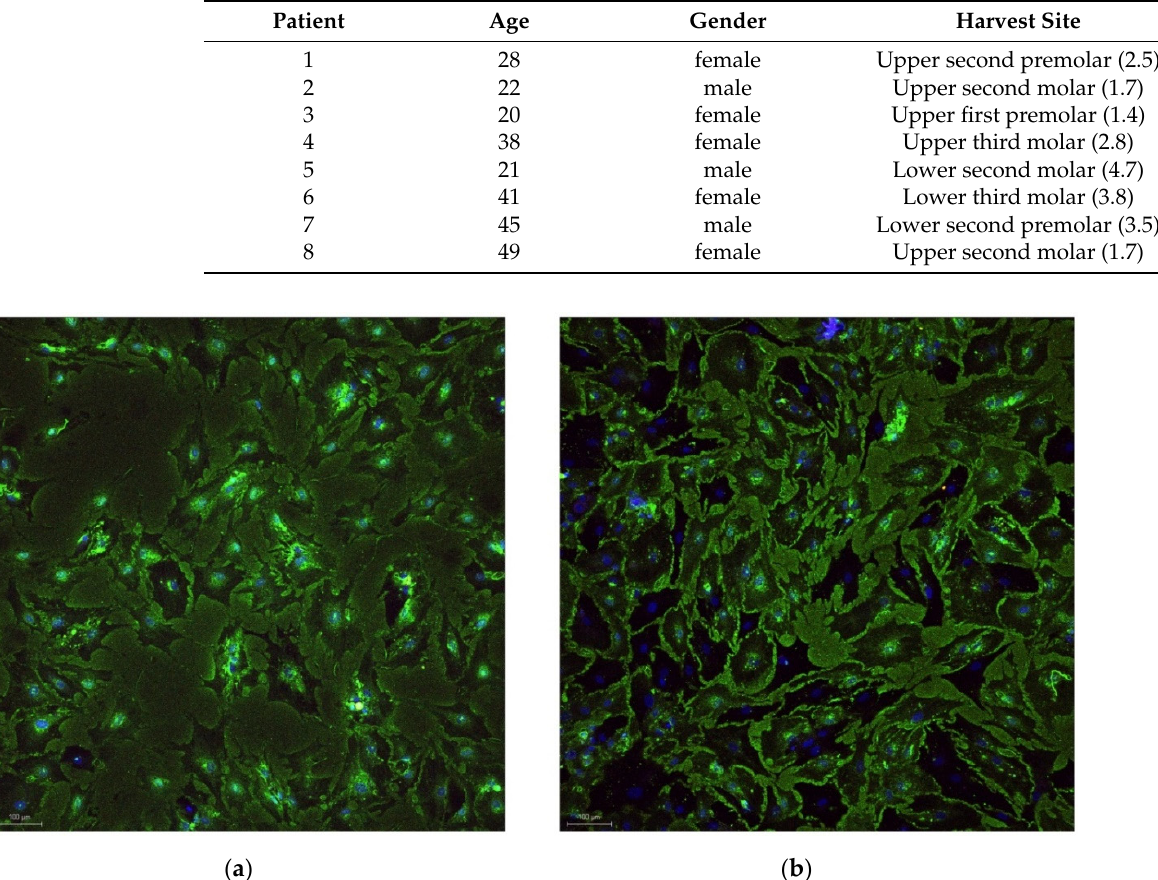
Figure 1. Confocal marker identification of osteoblasts stained for alkaline phosphatase and osteocalcin.: ( a ) laser “+” and ( b ) laser “-”.